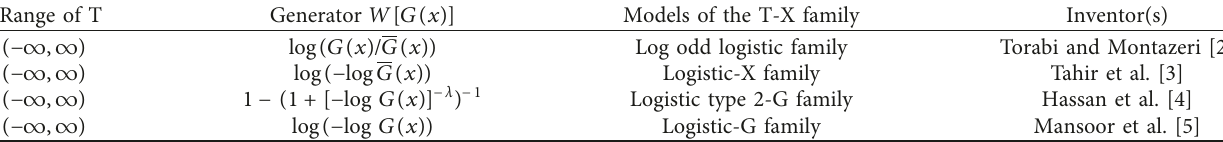
Table 1: The real line supporting generalizers and corresponding